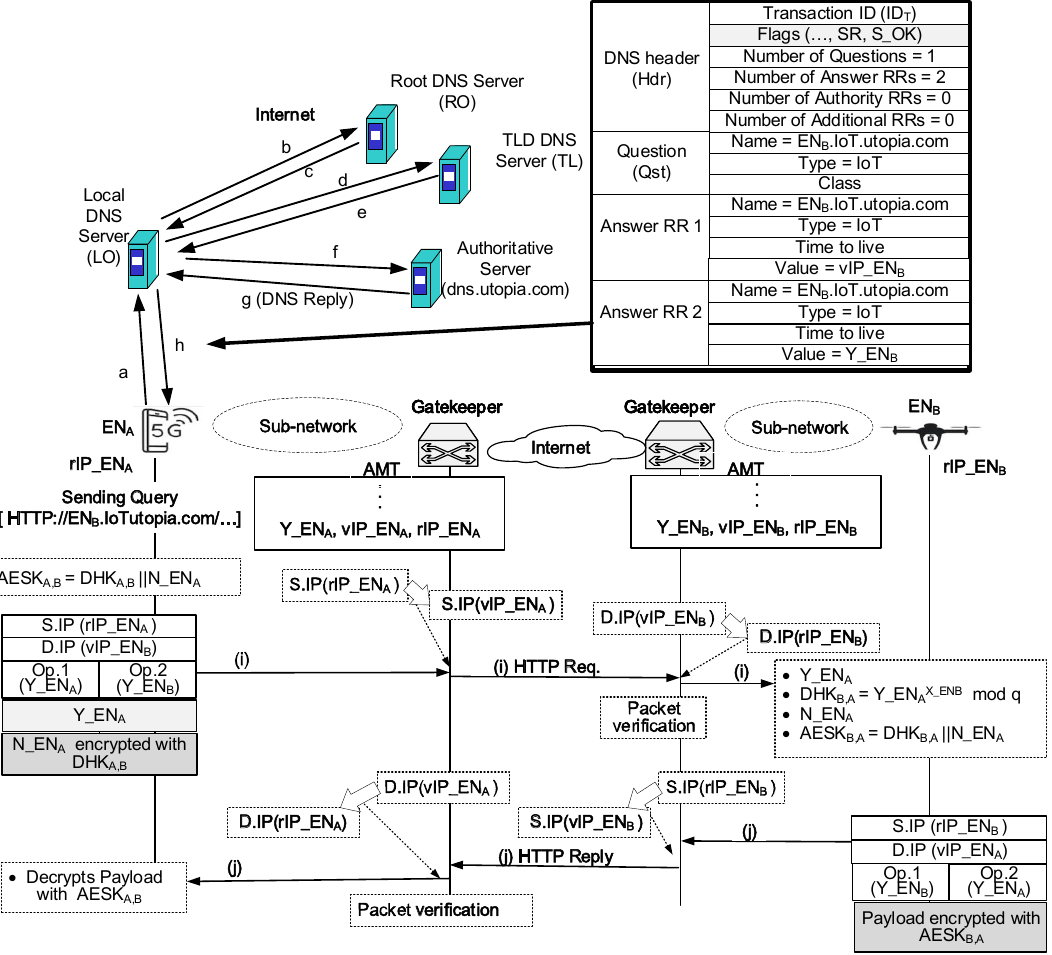
Figure 6. Secure HTTP communication over DNS-based Secure Gatekeeper